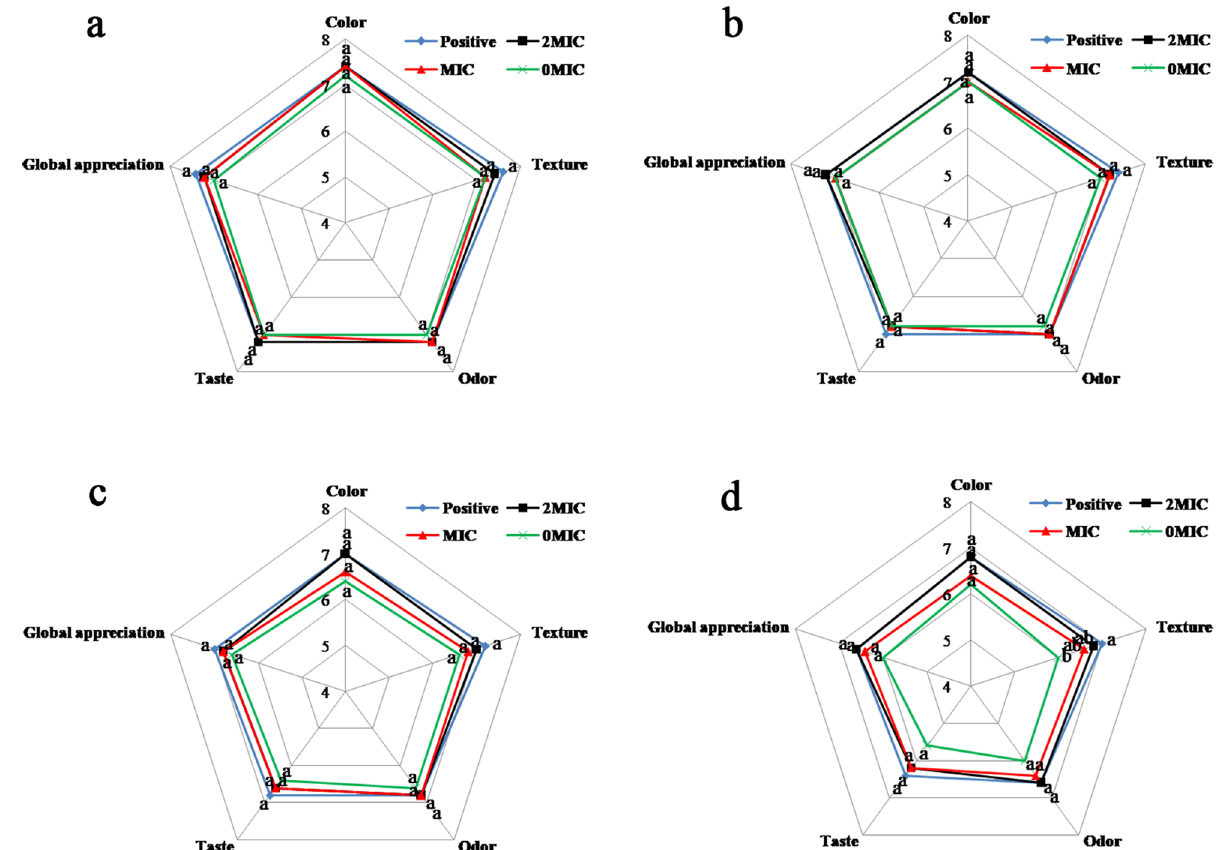
Figure 6. Radar plot of sensory properties of PCA applied to pork at different storage periods. ( a ) 1st, ( b ) 3rd, ( c ) 5th, and ( d ) 7th